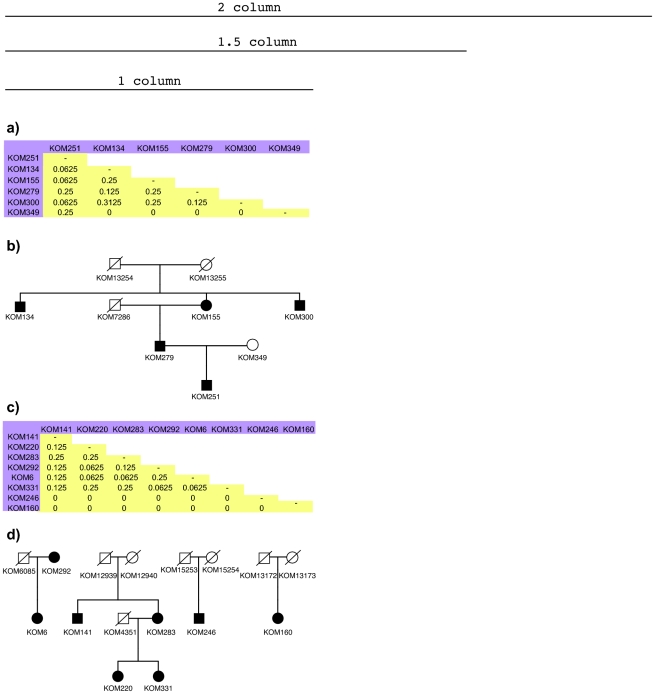
Two examples of segregation of CNVs in pedigrees: CNVR686 and CNVR54.(a) The kinship matrix of 6 carriers for CNVR686. They are all from the same population. The mean kinship coefficient of any pair of these 6 carriers is k691 = 0.175, which is significantly higher than the population mean (adjusted p value<0.001) (b) The carriers for CNV686 placed in pedigree. Squares indicate male sex, circles indicate female sex. Filled squares or circles indicate CNV carriers. A cross through a square or a circle indicates the individual is either deceased or ungenotyped. (c) The kinship matrix of 8 carriers for CNVR54. They are all from the same population. The mean kinship coefficient of any pair of these 8 carriers is k55 = 0.078, which is significantly higher than the population mean (adjusted p value<0.001) (d) The inheritance of CNV54. The key to the pedigree presentation is the same as for section (b).